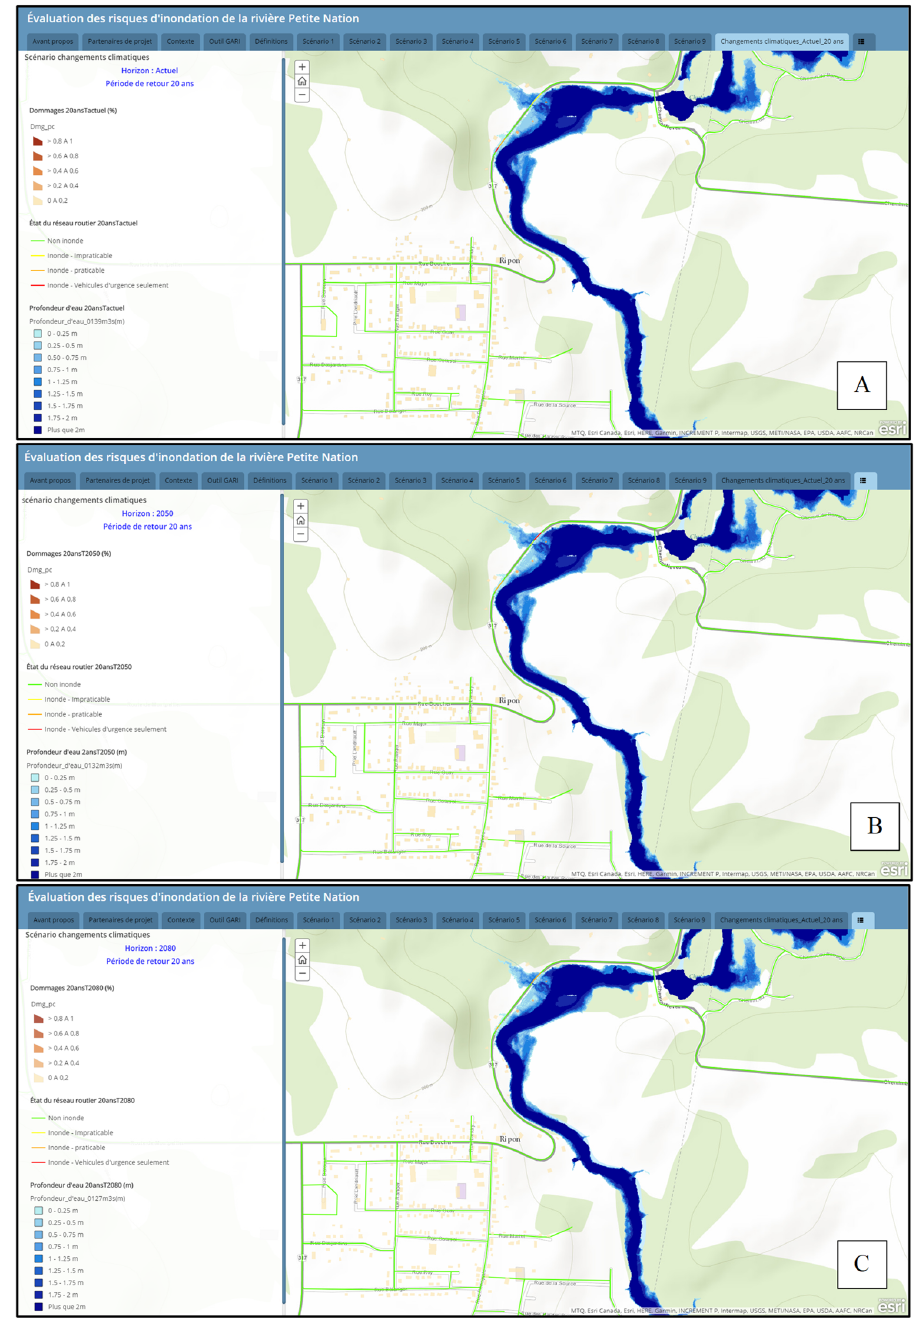
Figure 6. Screenshot of slides 14 ( A : current with a 20-year return period), 15 ( B : 2050 with a 20-year return period) and 16 ( C : 2080 with a 20-year period) (https://arcg.is/OvP98, accessed on 1 September